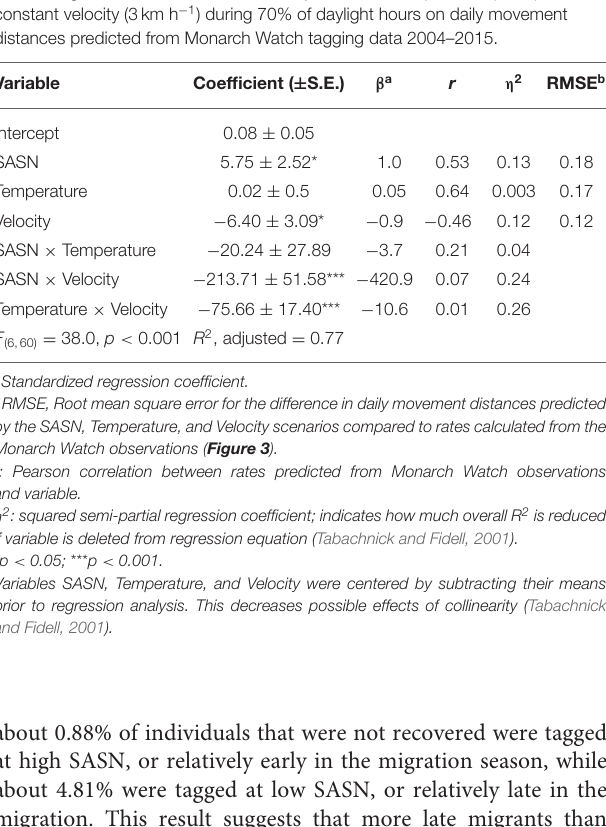
( Figure 6 ). SASN values at latitude and DOY of tagging for monarchs that are recovered in Mexico were a subset of SASN values of monarchs whose tags were not recovered ( Figure 7 ).